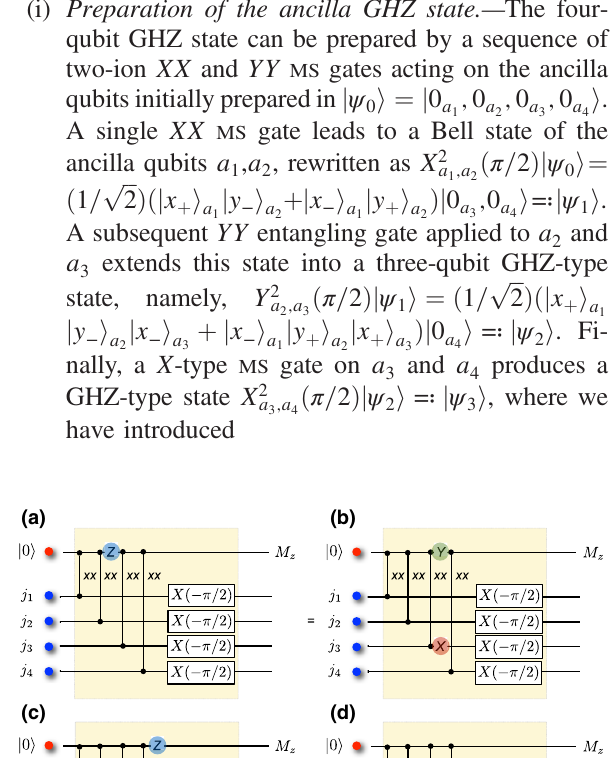
FIG. 6. Stabilizer readout based on sequential two-qubit MS gates: X -type ( α ¼ x ) and Z -type ( α ¼ z ) stabilizer readout gates [Eq. (8)], depicted circuits, using sequential two-ion MS X 2 0 ;j by solid lines with black dots between the single ancilla qubit and each of the data qubits involved in a particular stabilizer, and with an XX label that defines the basis of the entangling gate [Eq. (4)]. The MS gates have to be combined with single-qubit rotations π = 2 Þ ; Y π = 2 Þ on the data qubits [Eq, (25)] to achieve the X j ð j ð(cid:3) stabilizer mapping [Eq. (26)]. The measurement of the ancillary qubit in the computational basis is denoted as M z 0 .